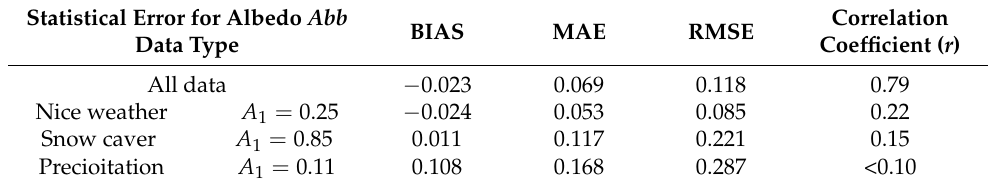
Table 7. Same as Table 6 but for the Beljaars and Bosveld [38] method for the estimation of albedo. Statistical Error for Albedo